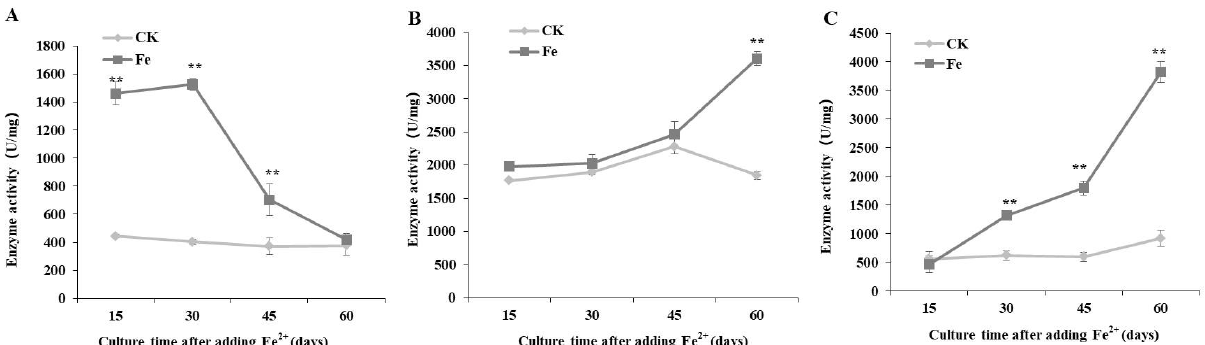
Figure 3. Dynamic changes in phosphoglucose isomerase ( A ), phosphoglucomutase ( B ), and UDPG- pyrophosphorylase ( C ) production by Lentinula edodes 808 (ACCC 52357) over 60 days of static cultures after Fe 2+ addition. CK: control without Fe 2+ addition; Fe: as FeCl 2 , 200 mg/L of Fe 2+ added after 7 days of shaking at 150 rpm and 3 days of static culture. Data are the means of experiments in triplicate ± SD. Asterisks indicate a significant statistical difference at p < 0.01 (**) and p < 0.05 (*), according to the LSD test. Table 1. Correlation coefficients between the intracellular polysaccharide (IPS) and exopolysaccharide